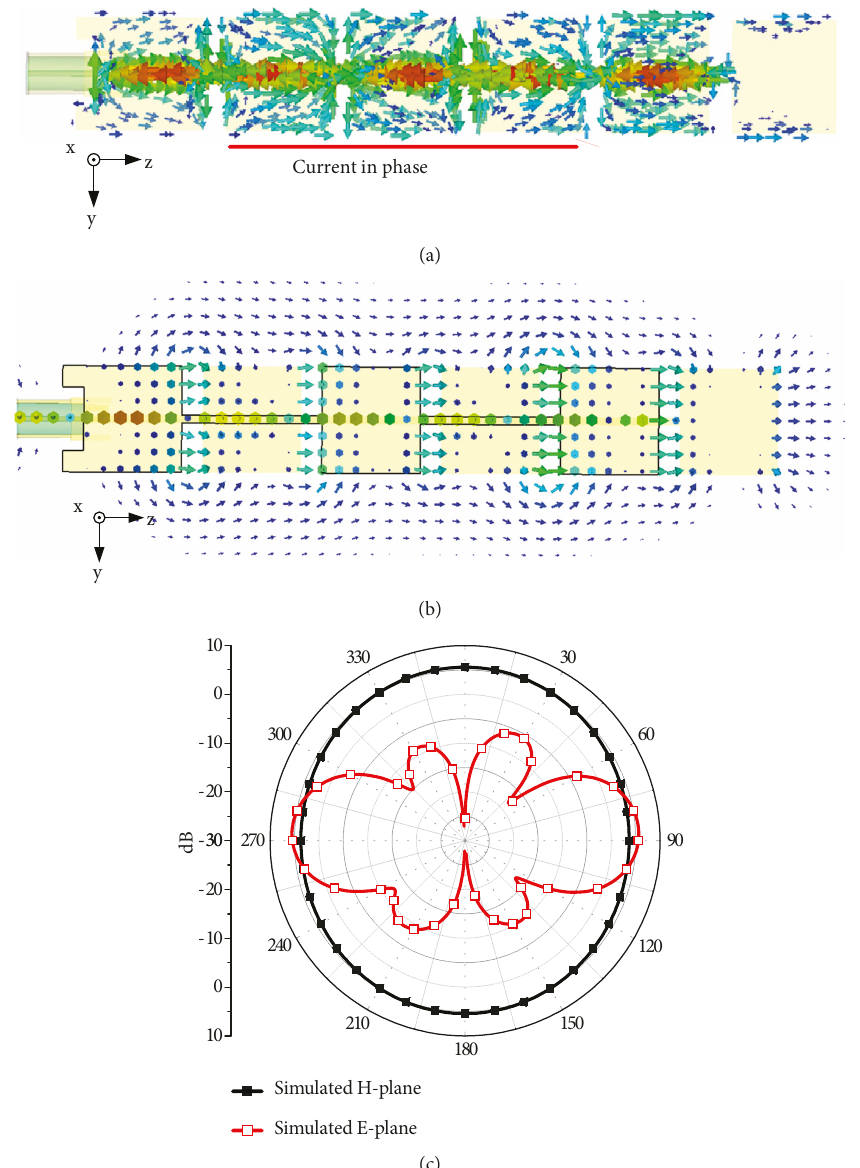
Figure 2: (a) The current distribution of the driven element of the proposed antenna structure. (b) The electric fi eld distribution of the driven element of the proposed antenna structure. (c) The simulated pattern of the driven element at